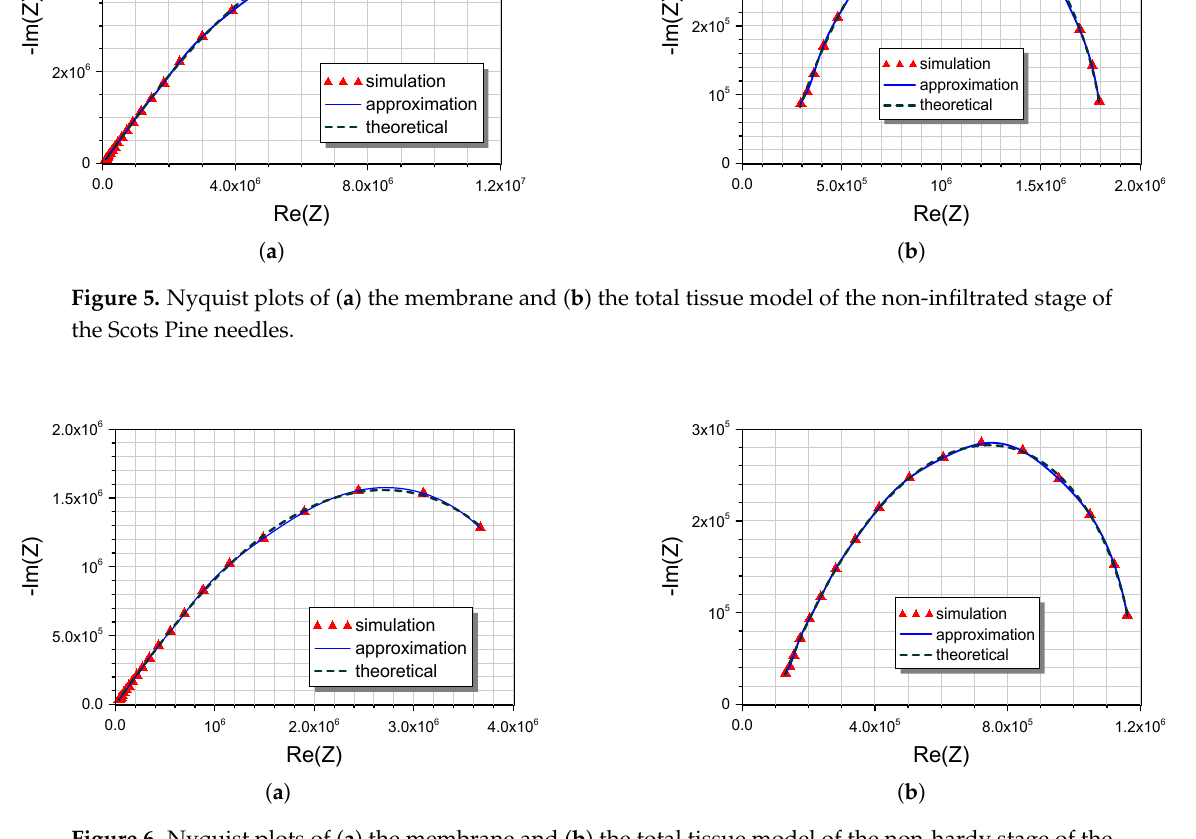
Figure 6. Nyquist plots of ( a ) the membrane and ( b ) the total tissue model of the non-hardy stage of the Scots Pine needles.